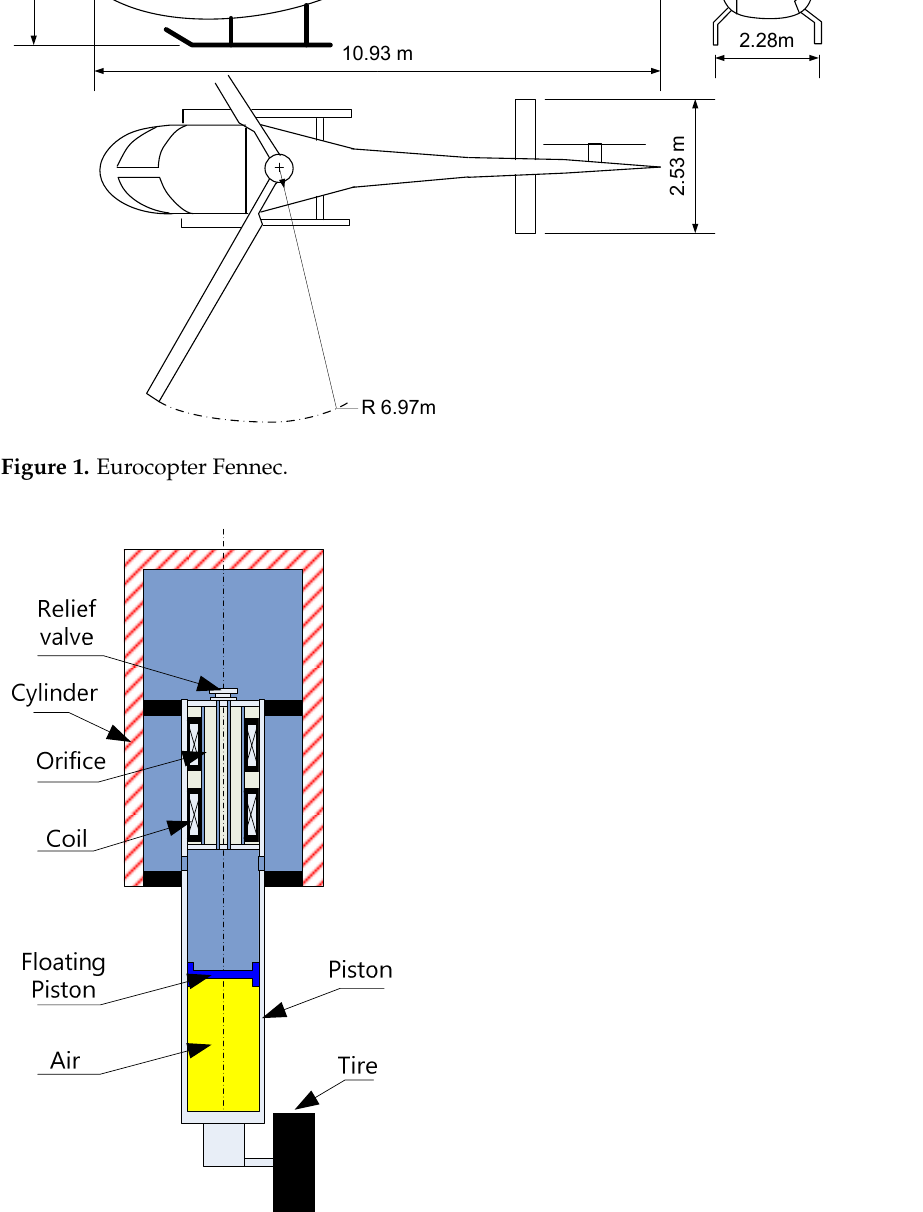
Figure 2. Structure of a landing gear equipped with an MR damper.